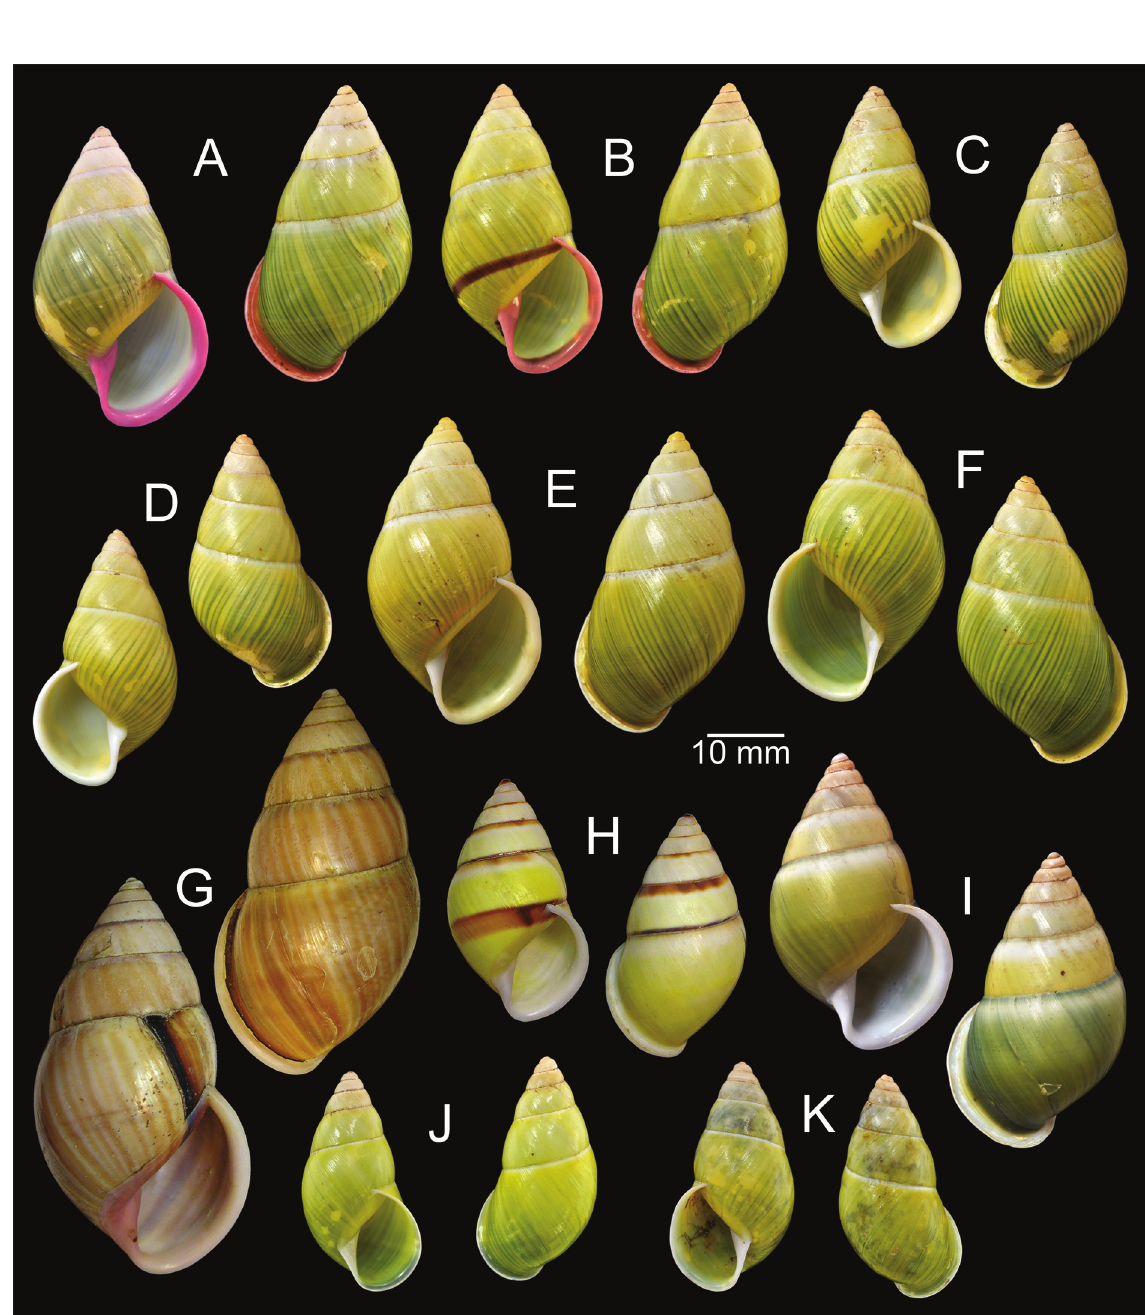
Fig. 4. Shells of Amphidromus ( Amphidromus ) spp. A−F . Amphidromus roseolabiatus Fulton, 1896. A–B . Typical form from Ban Phavong, Khammouan, Laos (CUMZ 7011). C–D . Form with white lip from Nam Turn Bridge, Bolikhamxay, Laos (CUMZ 7006). E–F . Form with white lip from Tam Mung Korn, Bolikhamxay, Laos (CUMZ 7004). G . Amphidromus laosianus Bavay, 1898 from Khone, Champasak, Laos (RMNH 101049). H . Amphidromus protania Lehmann & Maassen, 2004, holotype (RMNH 98143). I . Amphidromus givenchyi Geret, 1912 from Thad Lor Waterfall, Salavan, Laos (CUMZ 7015). J–K . Amphidromus syndromoideus sp. nov. from the type locality. J . Holotype (CUMZ 7019). K . Paratype (CUMZ